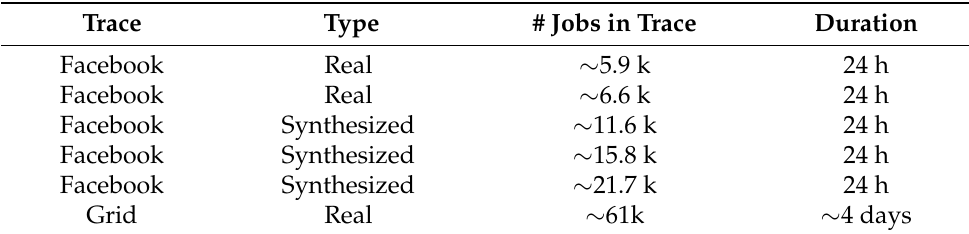
Table 4. Workload